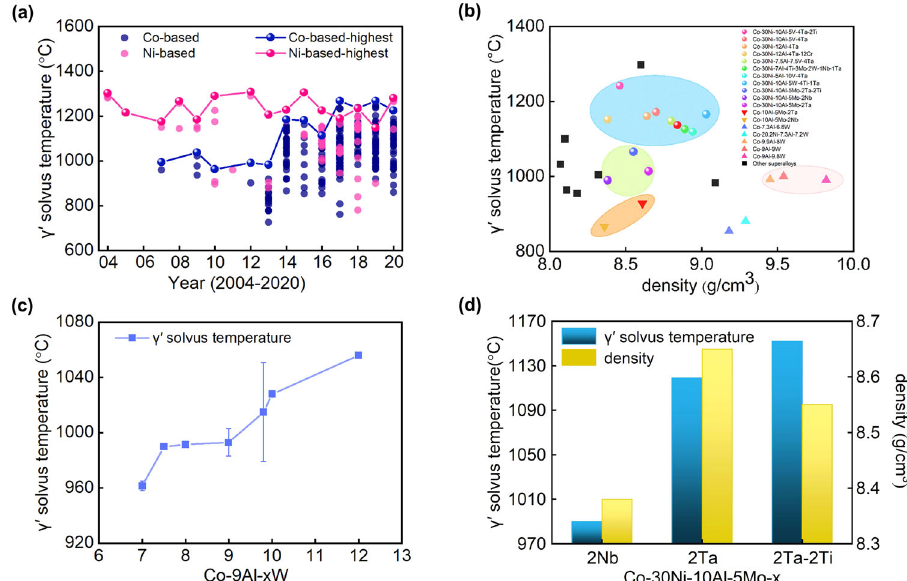
Fig. 6 Materials insights from the extracted data. a Extracted dataset of γ ′ solvus temperature published from year 2004 – 2020. b Ashby chart for γ ′ solvus temperature and density data. c Effect of element W on γ ′ solvus temperature of Co-9Al-xW alloy. d Effect of different elements (Nb, Ta, and Ti) on γ ′ solvus temperature and density of Co-30Ni-10Al-5Mo-x